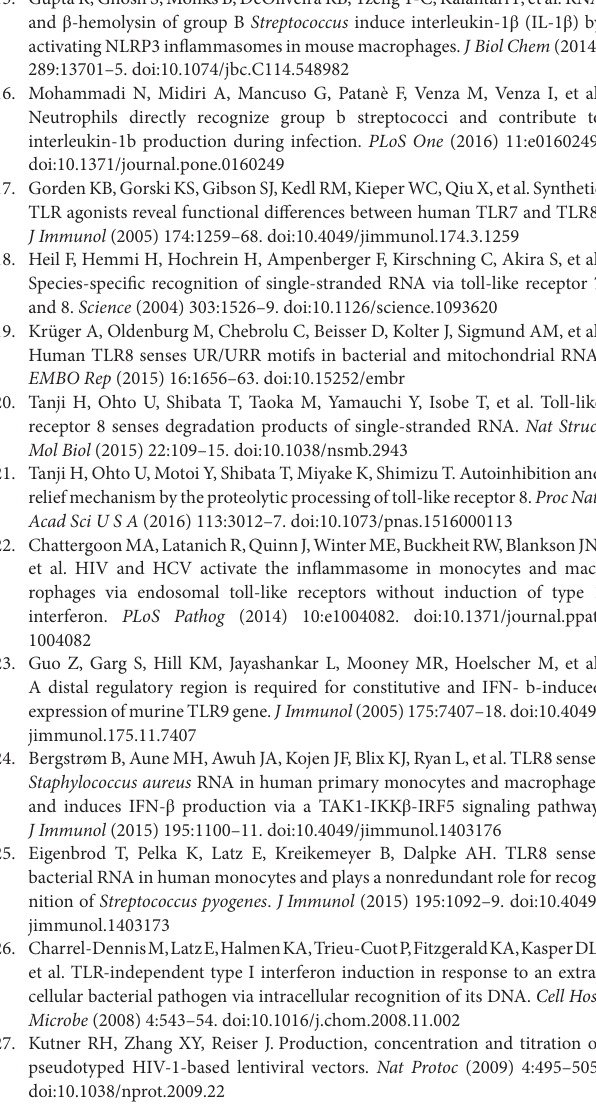
FigUre s7 | Efficiency and effect of gene silencing in MDM. (a) The level of expression of various targets after siRNA-mediated silencing relative to a non-targeting control (NTC) was determined by RT-qPCR ( n = 2–4). (B) Following successful gene silencing (right figure, n = 4) MDM were infected with E.